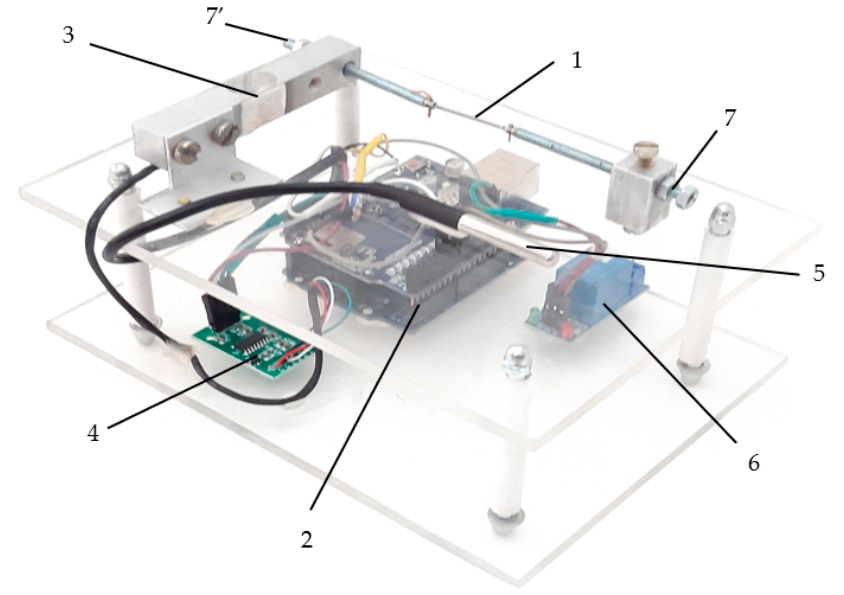
Figure 2. Experimental stand for testing nitinol fatigue resistance. 1—nitinol element; 2— microcontroller system; 3—force sensor; 4—adapter for force sensor; 5—temperature sensor; 6— power relay self-heating system Ni-Ti; 7, 7 ′ —supply terminals.